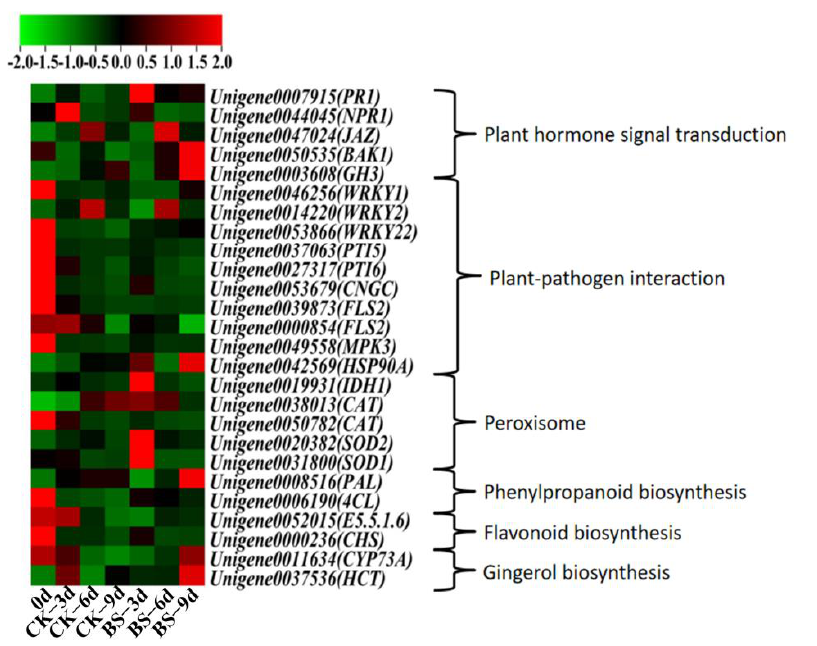
Figure 5. Heat map of gene expression profiles of six disease-resistant pathways that are signifi- cantly enriched in stored mango